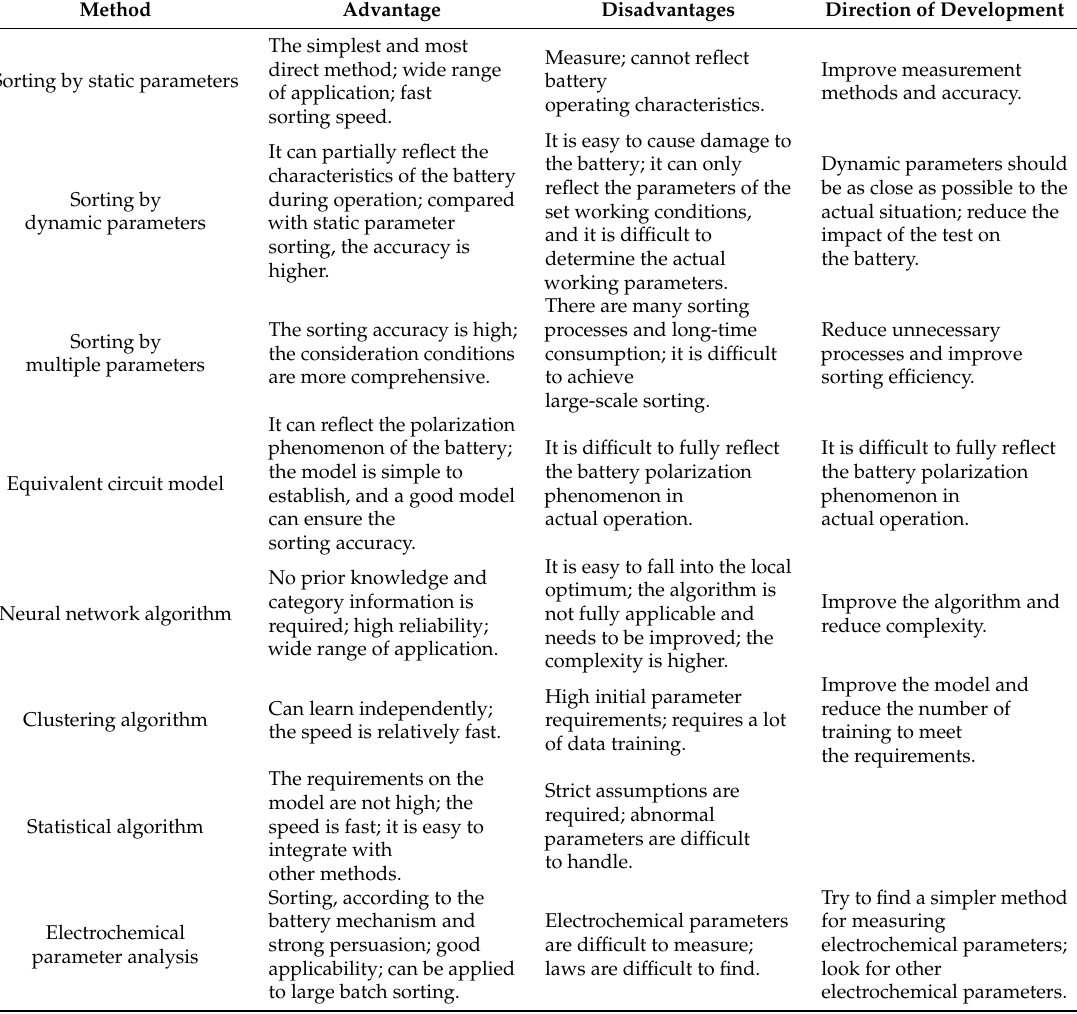
Table 1. Comparison of power battery sorting